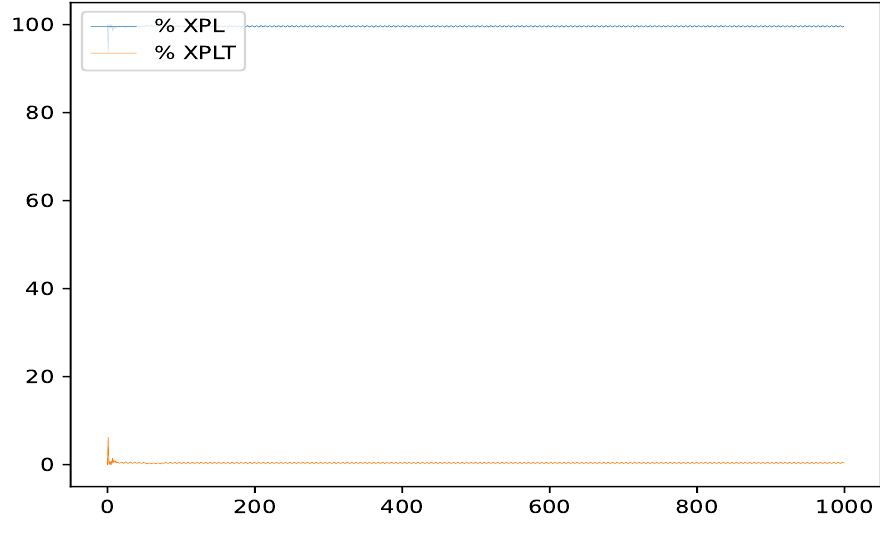
Figure 14. WOA-MIR-510 Dimensional Hussain.